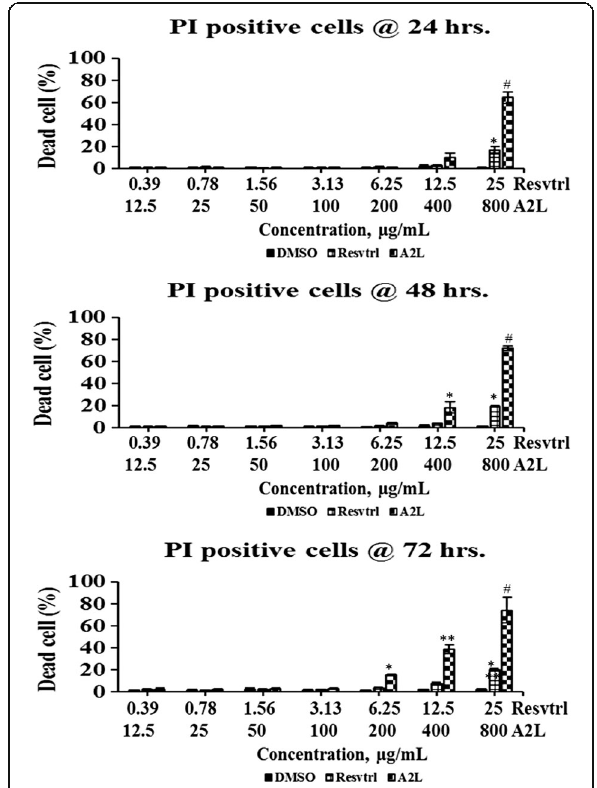
Fig. 2 Quantification of treatment-induced cell death. Concentration- and time-dependent assessment of cytotoxicity resulting from treatment of HepG2 cells with resveratrol or A2L followed up for three days. * p < 0.05; ** p < 0.01; # p <